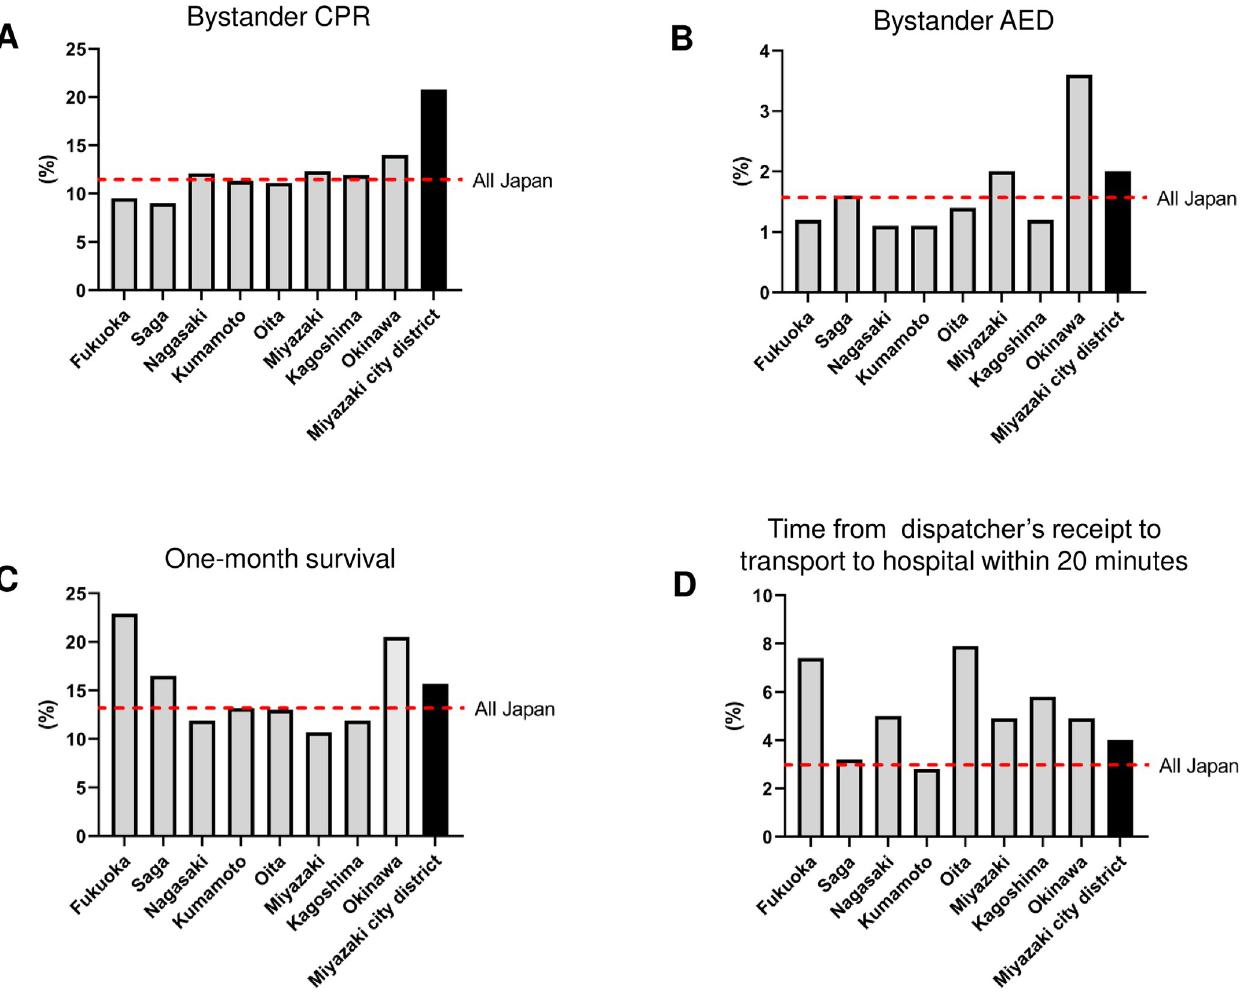
Fig 1. Percentage of bystander-witnessed CPR on OHCA due to cardiac causes (A) , and shocked AED (B) among EMS-transported patients with OHCA. (C) One-month survival rate for witnessed patients with OHCA of cardiac cause. (D) Percentage of EMS transport time that was less than 20 min. We accessed the annual report released by the Fire and Disaster Management Agency of Japan in 2020 and analyzed data from the Kyushu-Okinawa region and all over Japan between 2015 and 2019. The red dotted line indicates the percentage across 47 prefectures in Japan. Raw data are available in S1–S3 Tables.